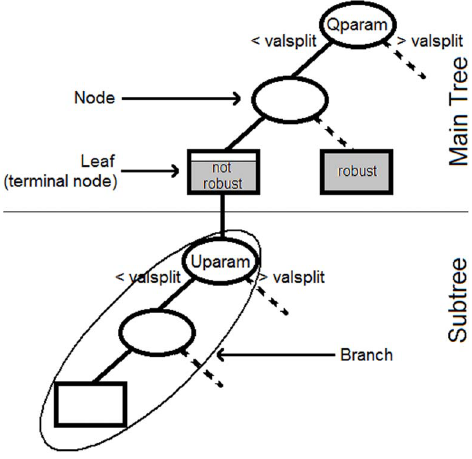
Figure 2. Successive use of trees for input parameters space exploration. The first tree (called the main tree) is built on management parameters only, as they are the main concern in the study. When management parameters do not allow robustly reaching management goals, trees (called subtrees) are built for each leaf of the main tree. The second set of trees is built on parameters identified as important by the sensitivity analysis. Results of interest are parameters values corresponding to branches (either of the main tree only or both the main tree and a subtree) leading to robust leaves.